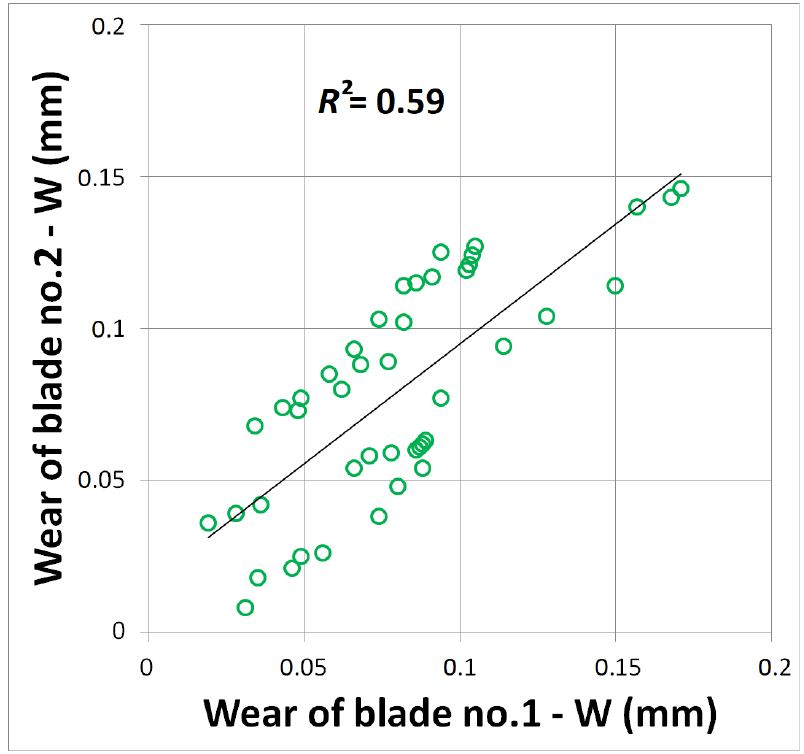
Figure 14. The correlation between the wear of two blades used in the same drill for tools belonging to Group C (experimental group containing four two-blade tools that were coated with “TiAlN/a - C:N”).